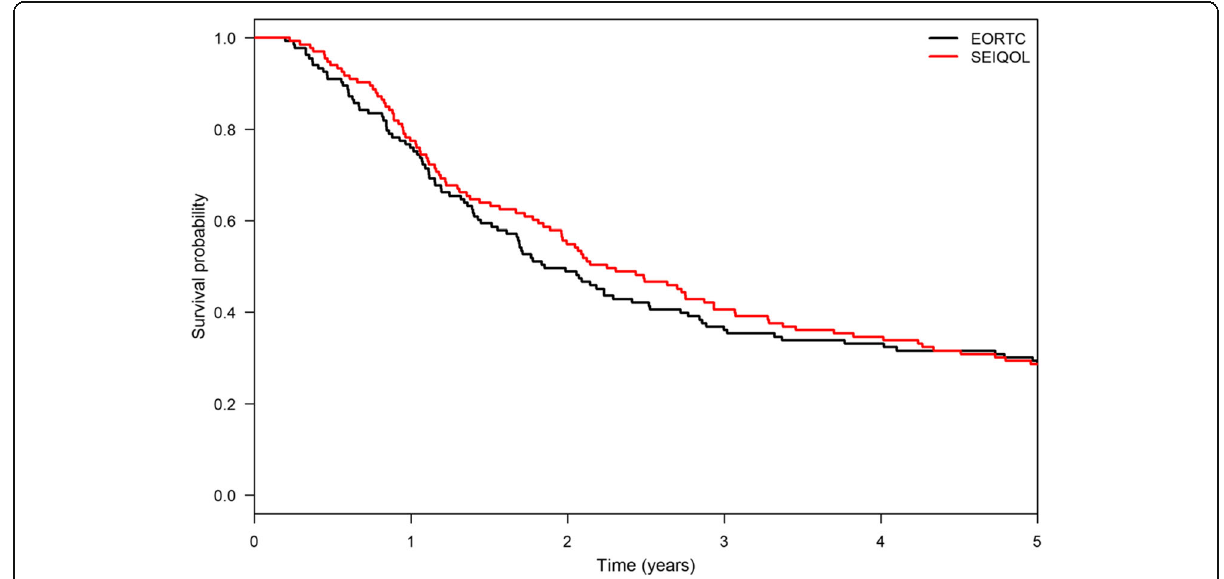
Fig. 3 Kaplan-Meier curve for EORTC versus